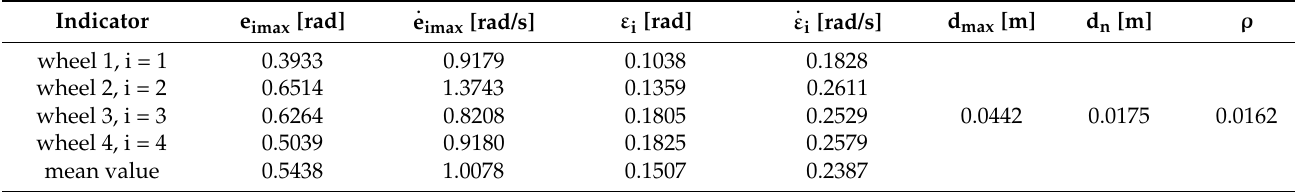
Table 2. Quality indicators for neural control